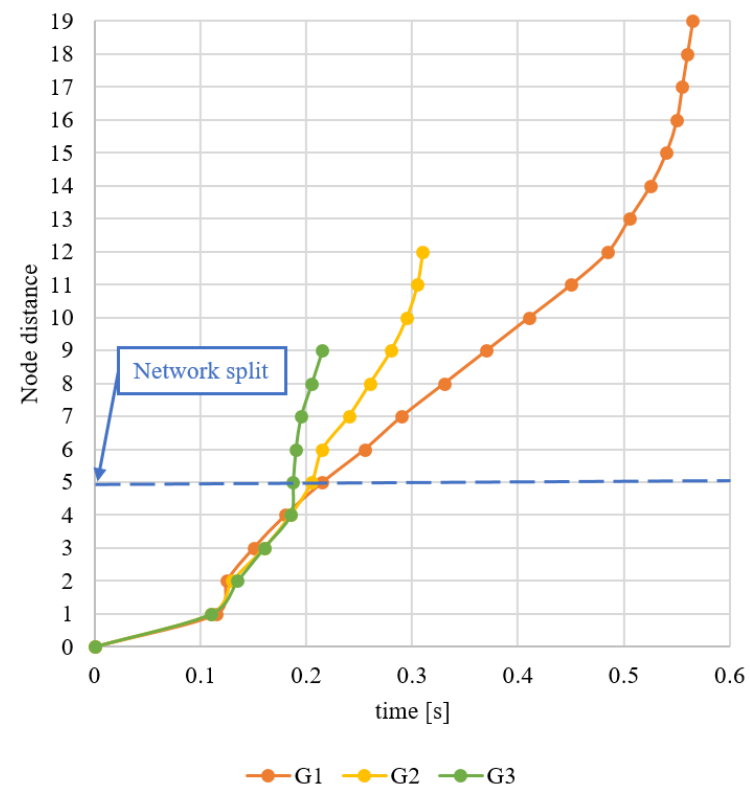
Figure 6. RoCoF wave position with respect to time.